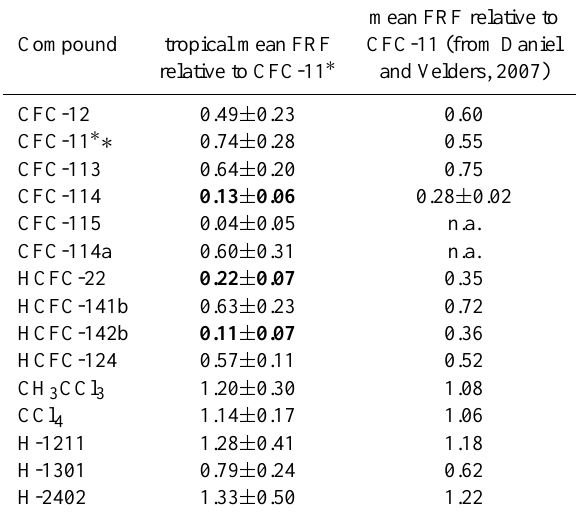
∗ averaged for mean ages between 2.0 to 4.8 years; ∗ ∗ CFC-11: absolute averaged FRF is given n.a. not available, model derived values were used for ODP